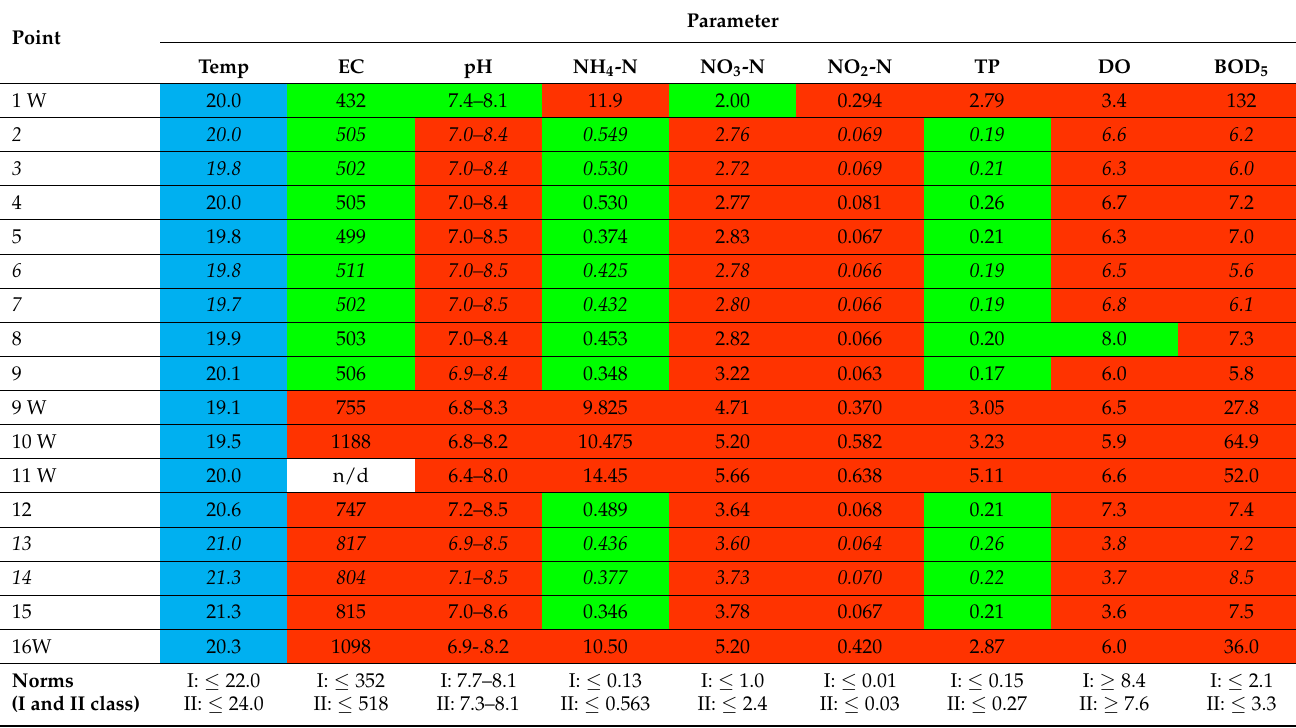
Table 8. The state of physicochemical elements at own points and points tested by WIO´S [81,83].